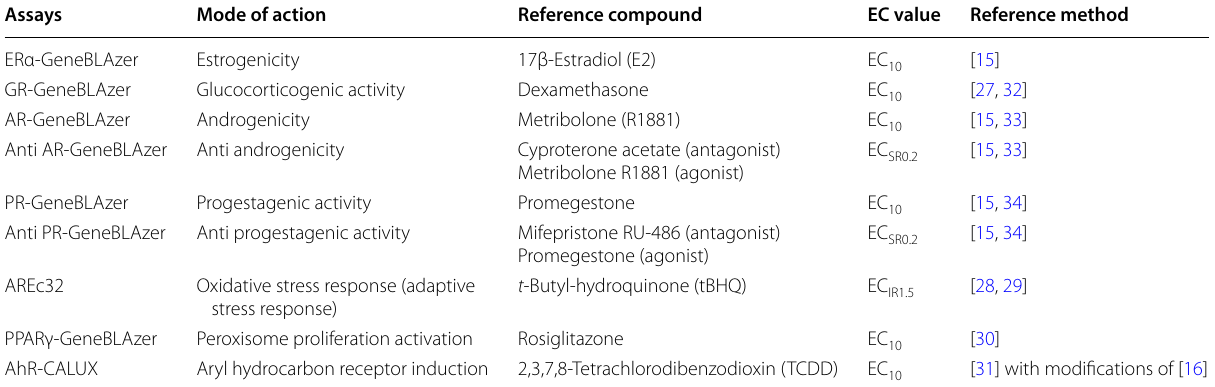
Table 2 Overview of the in vitro bioassays, endpoints, reference compounds, EC values and literature source of the methods [EC : Concentration causing 10% effect relative to the maximum triggered by a positive control (Eq. 3); 10 EC : Concentration causing an induction ratio of 1.5 (Eq. 4); EC IR1.5 in the presence of the agonist (Eq.